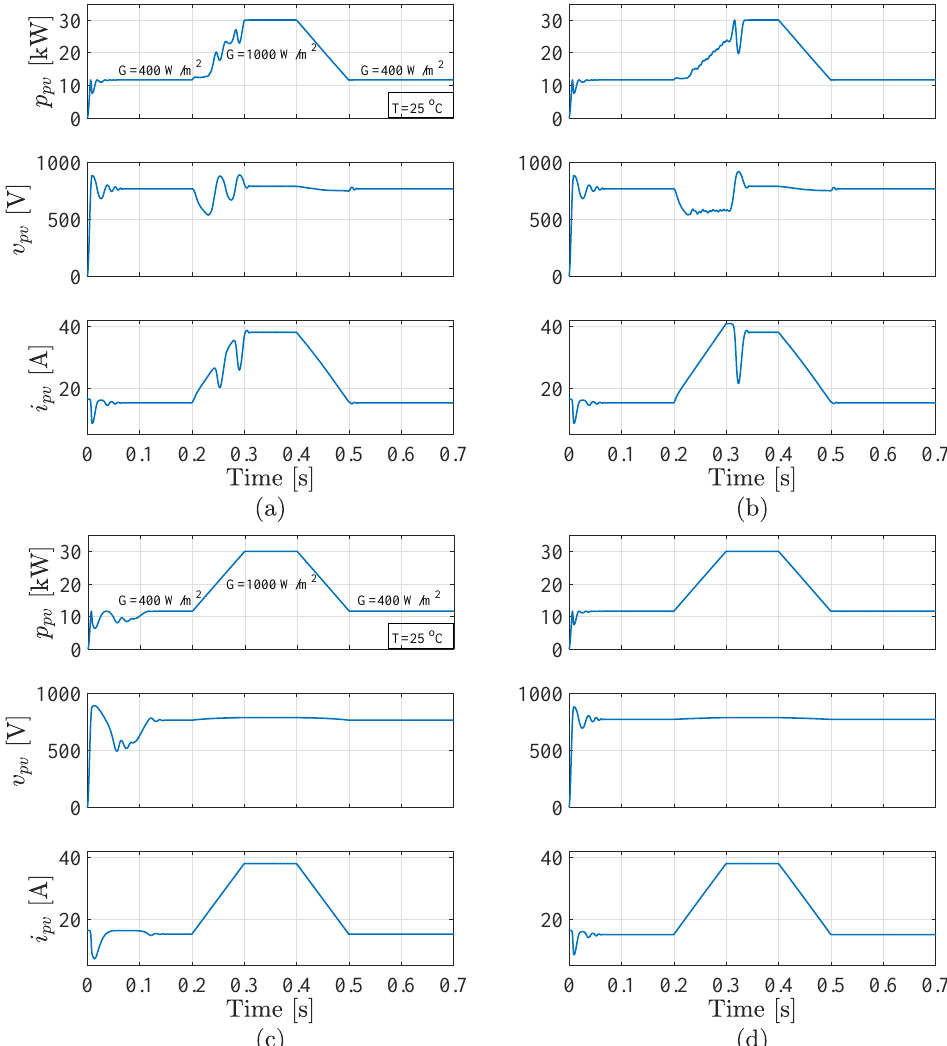
Figure 15. MPPT performance with a ramp radiation profile: ( a ) P&O method; ( b ) modified P&O; ( c ) multi-power-sample method; ( d ) the proposed model-based